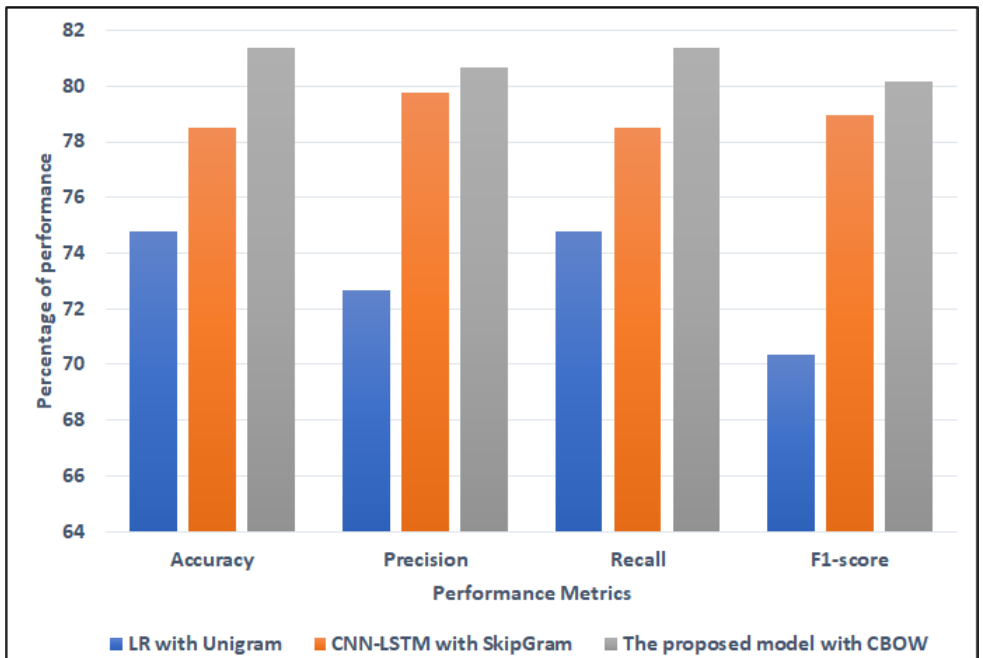
Figure 10. The best models for the ASTD